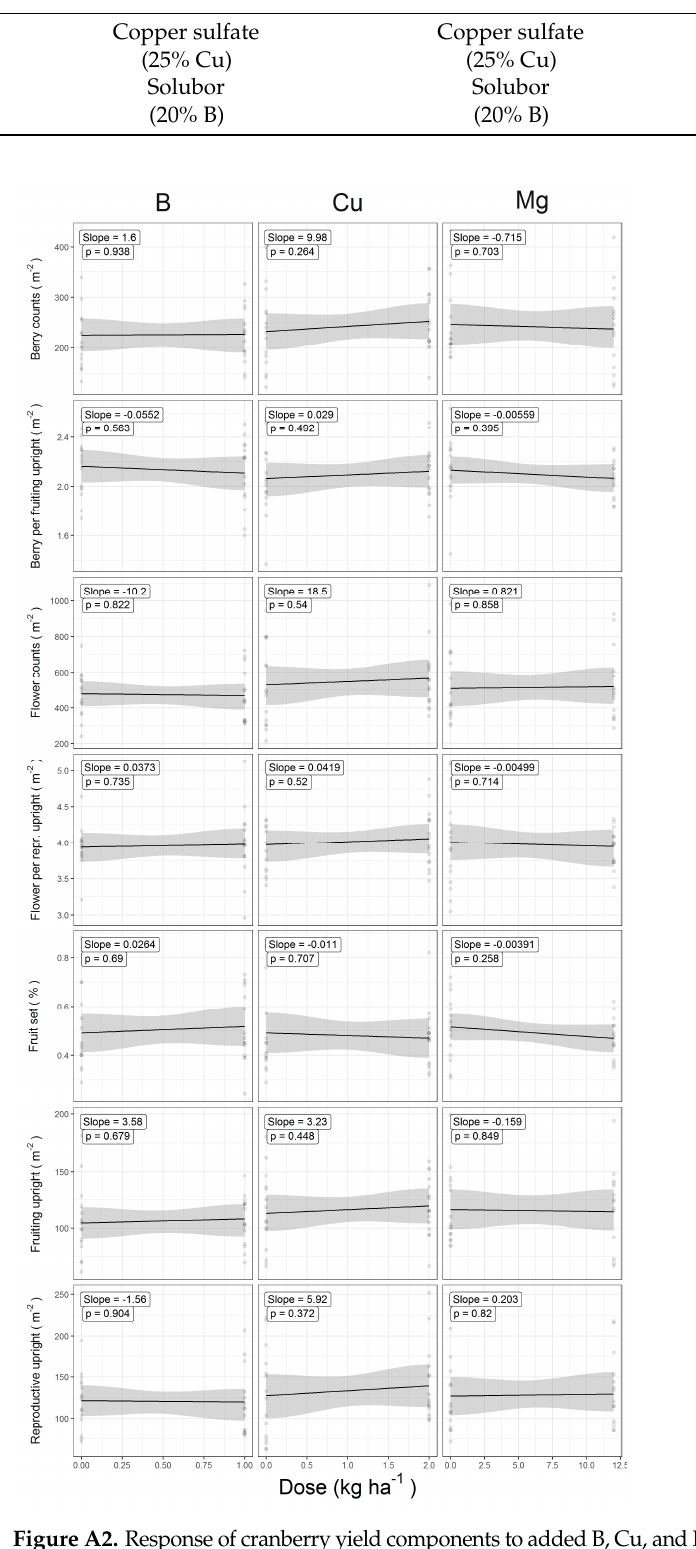
Figure A2. Response of cranberry yield components to added B, Cu, and Mg. The solid line represents the model fit with the slope and intercept of the line; the shaded area represents the 95% confidence